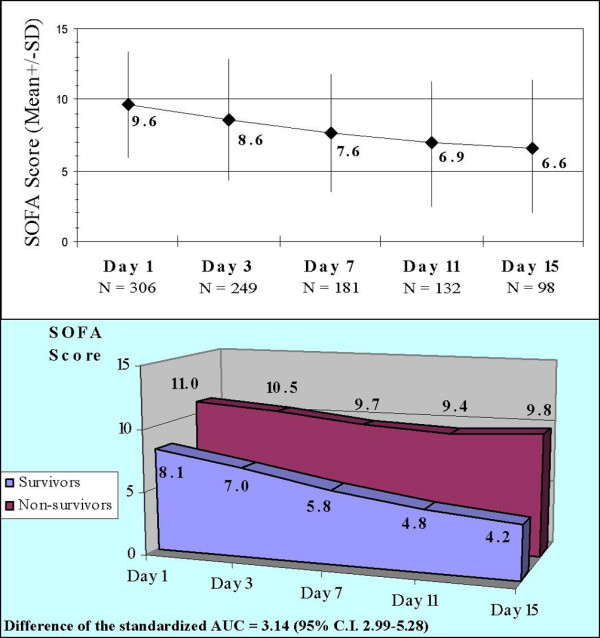
Evolution of the SOFA score over time. Upper panel: entire group of patients. Lower panel: area under the curve (AUC) of the Sepsis-related Organ Failure Assessment (SOFA) score trends in survivors and non-survivors. CI, confidence interval of the difference of the standardised AUC between survivors and non-survivors; SD, standard deviation.